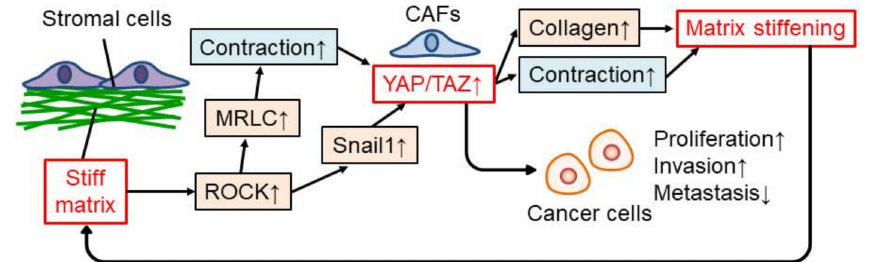
Figure 3. Regulation and function of YAP/TAZ in stromal cells modulated by stiff matrix. ↑ : upregu- lation, ↓ :